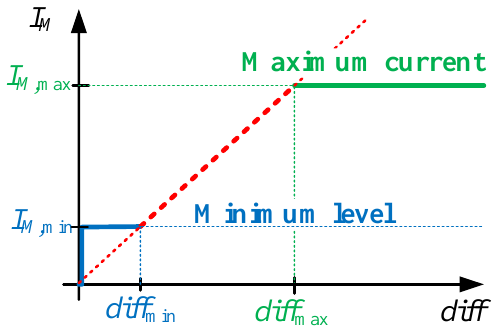
Fig. 5. Linear relation between the MOSFET current and the difference between the cell voltage and its